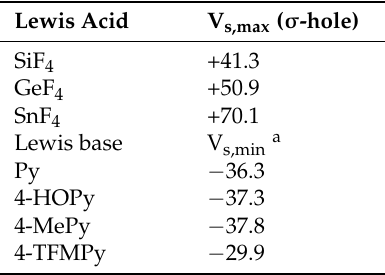
Figure 1. MEPs of isolated SiF 4 and Lewis base ligands computed on the 0.001 a.u. isodensity surface at the MP2/cc-pVTZ level. Color ranges, in kcal/mol, are: red greater than 15, yellow between 8 and 15, green between 0 and 8, blue below 0 kcal/mol. Table 1. Molecular electrostatic potentials extrema (in kcal mol − 1 ) on the 0.001 a.u. contour of the electron density (V s,max and V s,min ) of isolated donors of σ -hole and π -hole as well as isolated Lewis bases used in this study, calculated at the MP2/cc-pvtz level of theory.